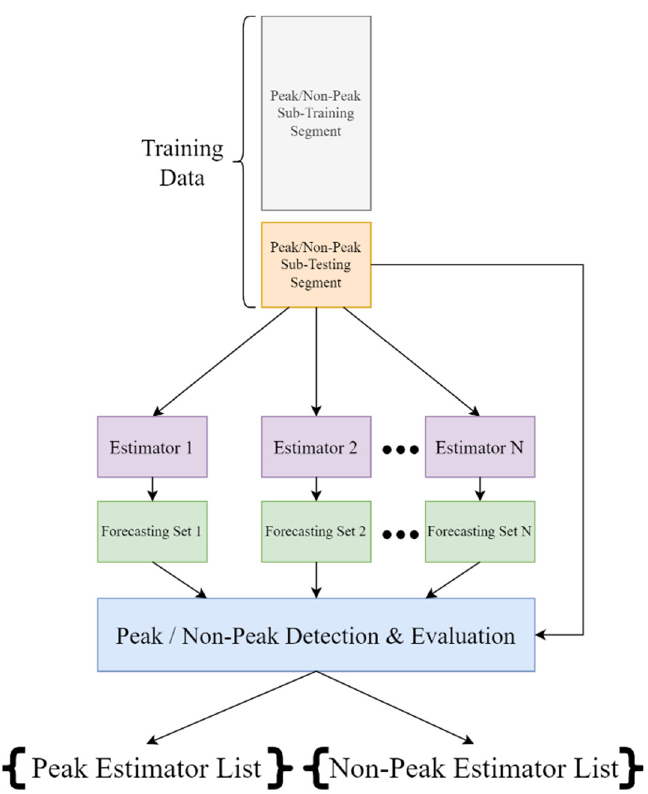
Figure 5. Ensemble membership selection process.